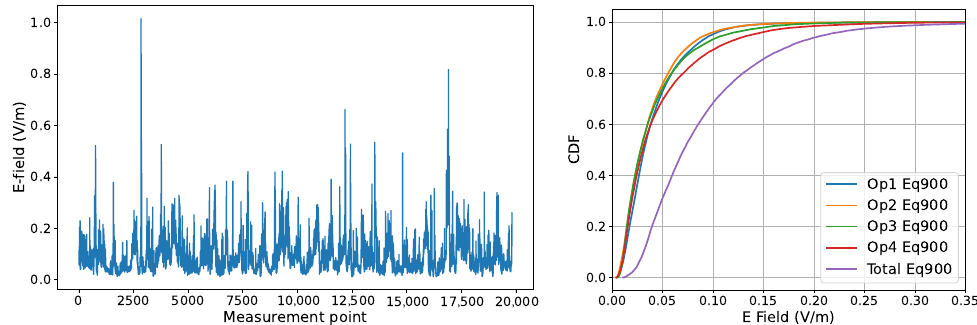
Figure 6. ( Left ): The variation of the total Eq900 along the drive path. ( Right ): CDF of total Eq900 and Eq900 from each operator.